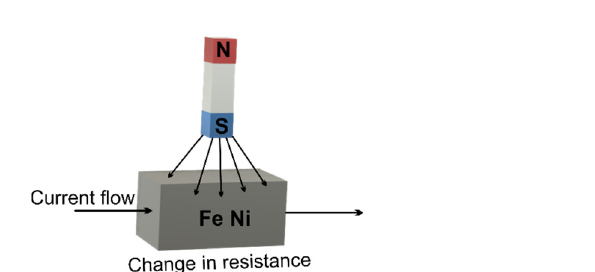
Figure 3. MEMS magnetometer—Magneto ‐ resistive effect.